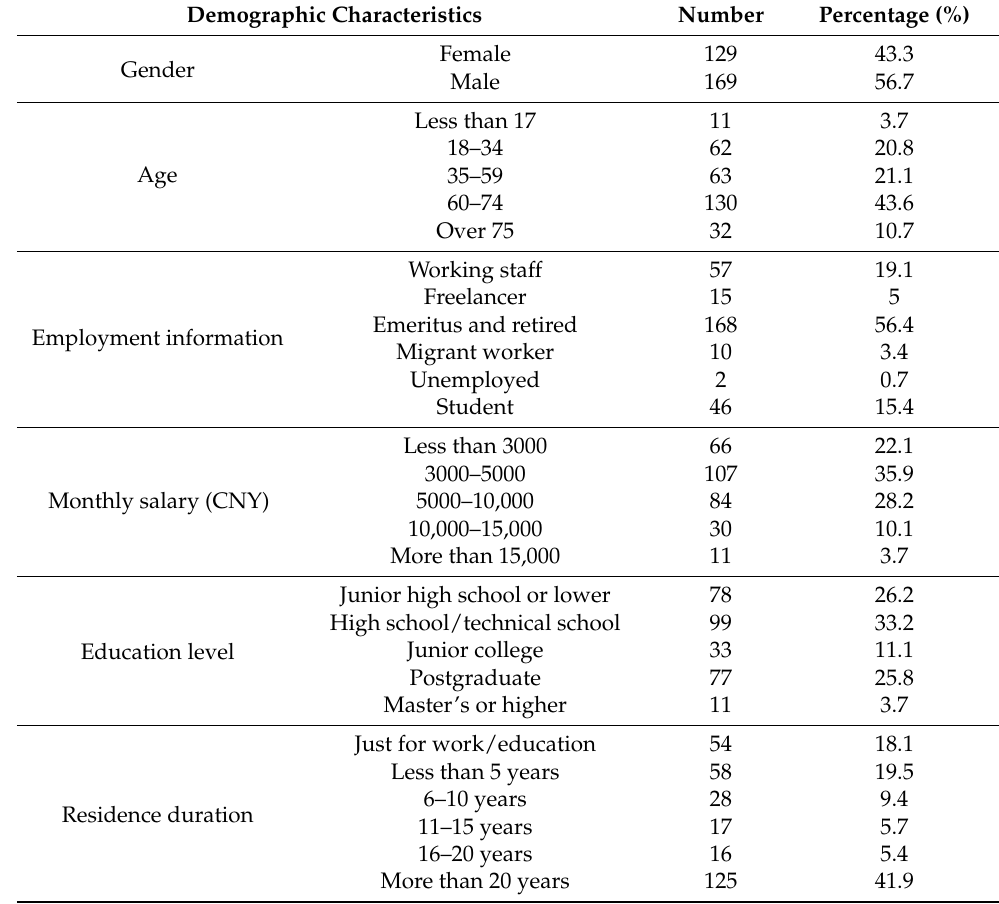
Table 2. Descriptive statistics ( n =